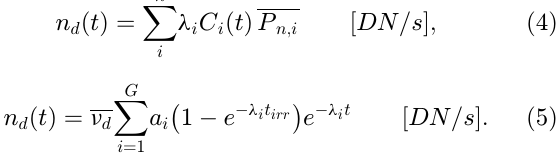
Fig. 1. Abundances